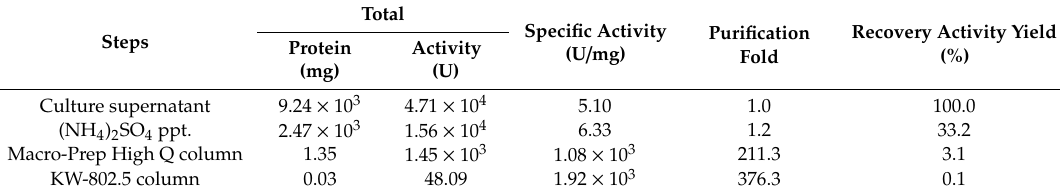
Table 2. Purification of the exochitinase from S. speibonae TKU048.